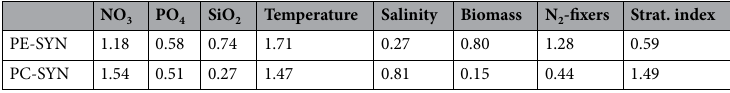
Table 1. VIP values of each variable.